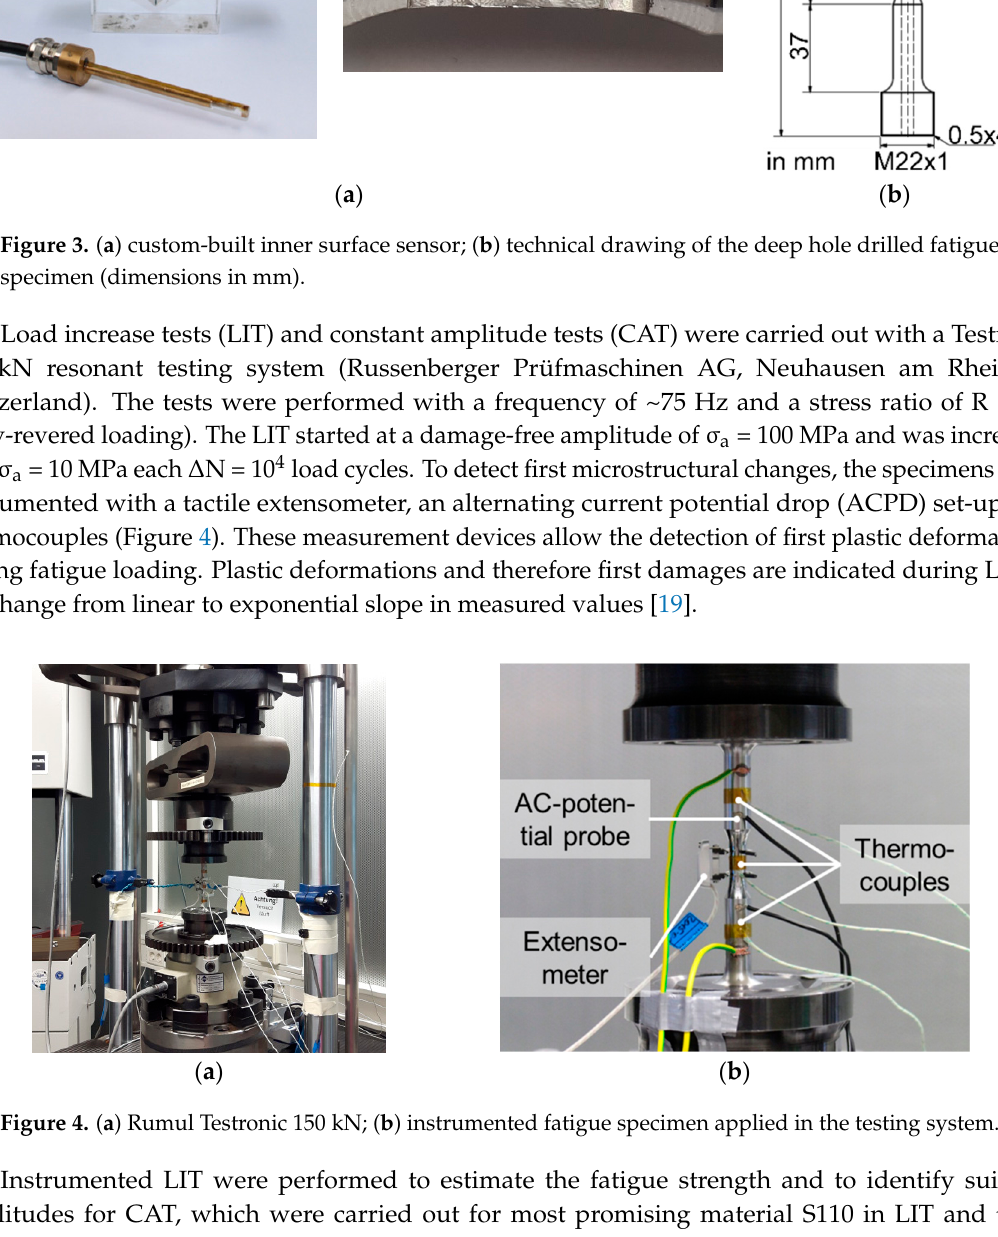
Figure 3. ( a ) custom-built inner surface sensor; ( b ) technical drawing of the deep hole drilled fatigue specimen (dimensions in mm).